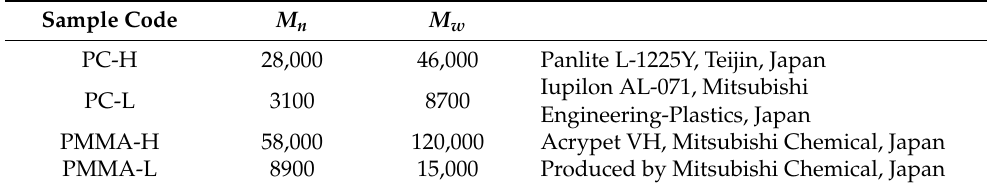
Table 1. Molecular weights of the